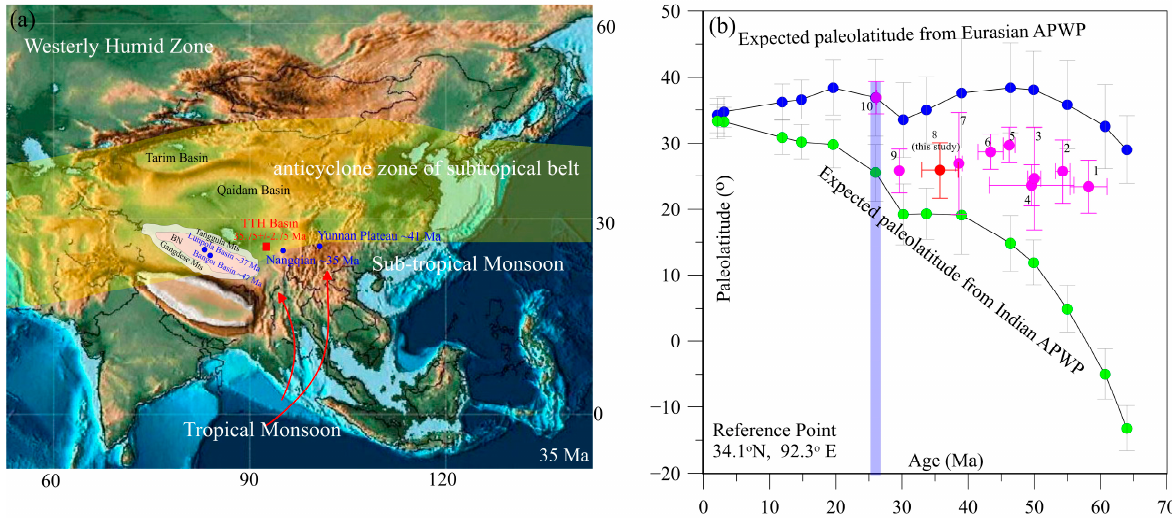
Figure 10. ( a ) Paleogeography and paleoclimatic configuration of Asia at ~35 Ma. The Lunpola and Bangor Basins and the Yunnan Tibetan Plateau are influenced by the tropical monsoon and sub- tropical monsoon [23,70–72]. BN indicates the Bangonghu–Nujiang lowland between the Gangdese Mts. and the Tanggula Mts. The red rectangle indicates the location of the study region. The Nangqian Basin record is from [75]. The paleogeography is modified from [71,76]. In addition, we moved the paleolatitude location of the Tibet reconstructed by [76] northward to a latitude of about 25 ◦ N,